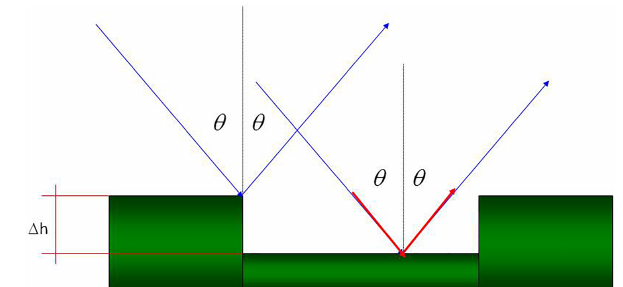
Figure 1. Rayleigh roughness definition.